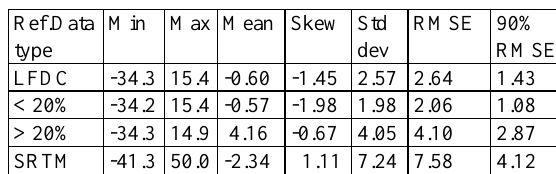
Table 4. Statistics obtained using difference DEM (TanDEM-X Jan 29, 2012 – LFDC) for Godavari test area.